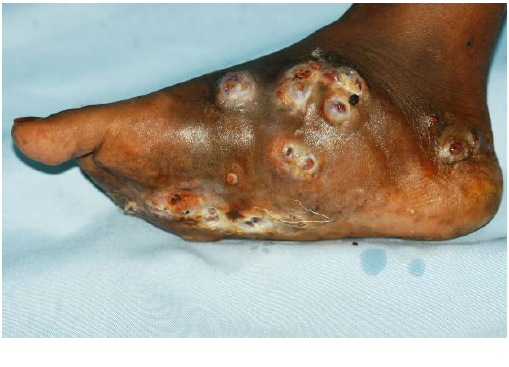
Figure 5. Foot eumycetoma with skin hyperpigmentation, multiple nodules, active sinuses discharging black grains discharge and local hyperhidrosis.